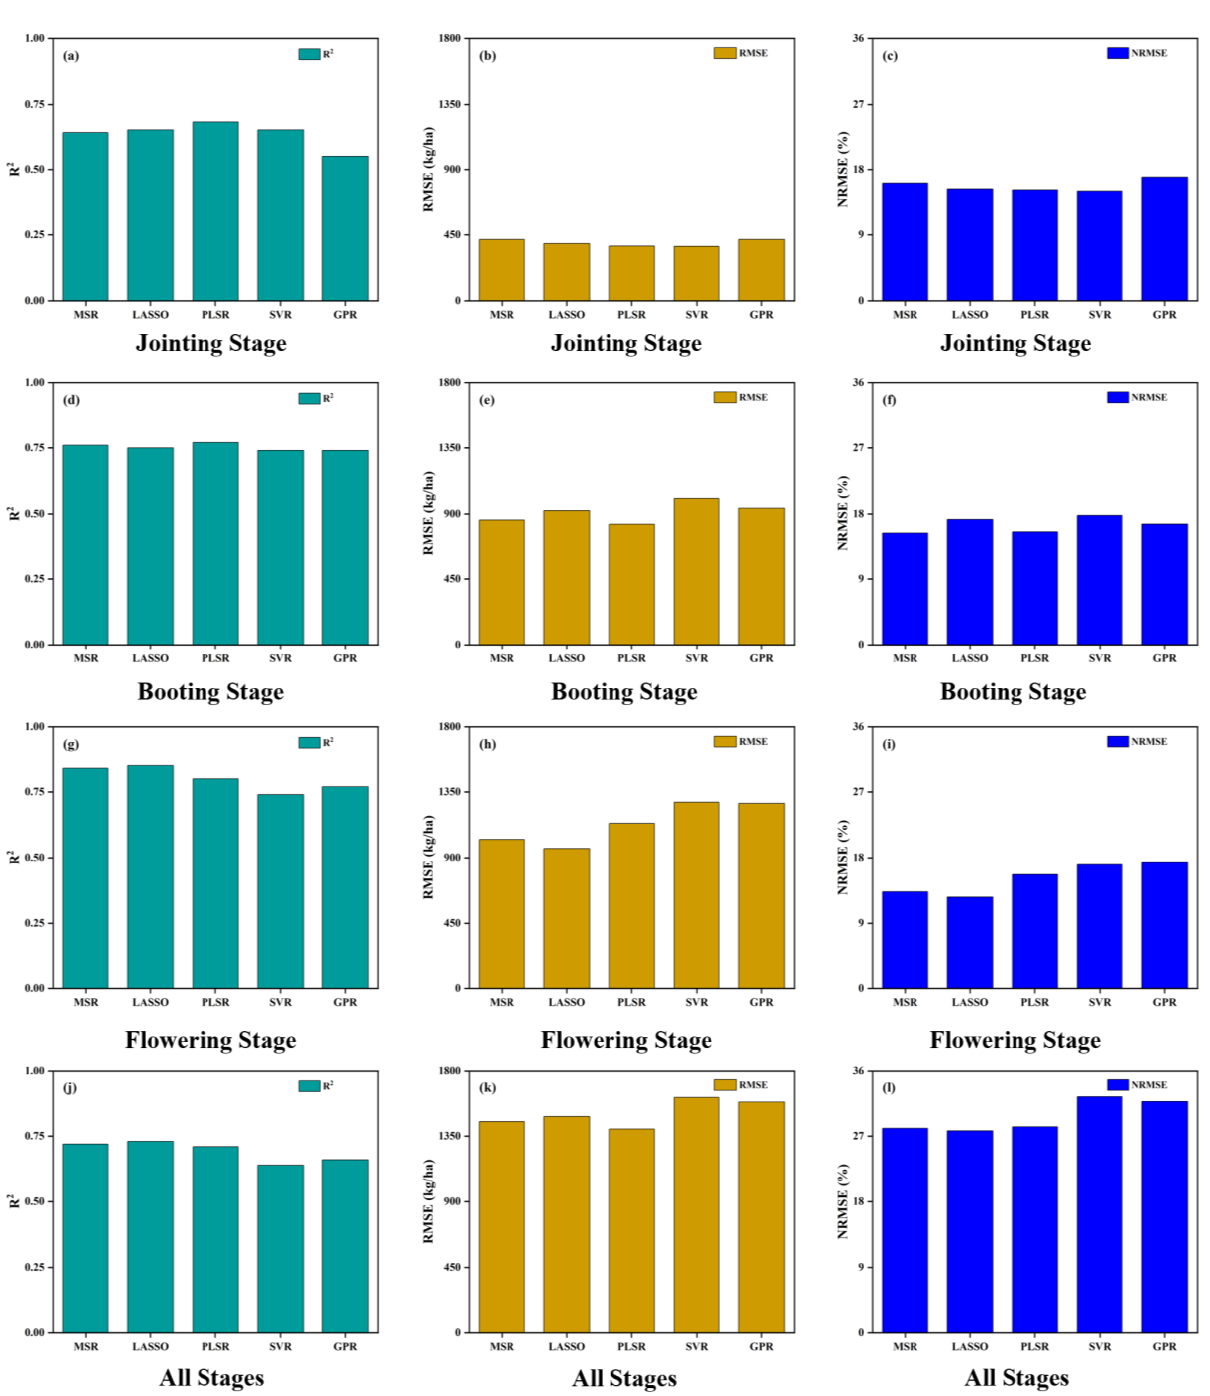
Figure 6. Results of the AGB estimation based on CIS at ( a – c ) jointing stage, ( d – f ) booting stage, ( g – i ) flowering stage, ( j – l ) all stages.